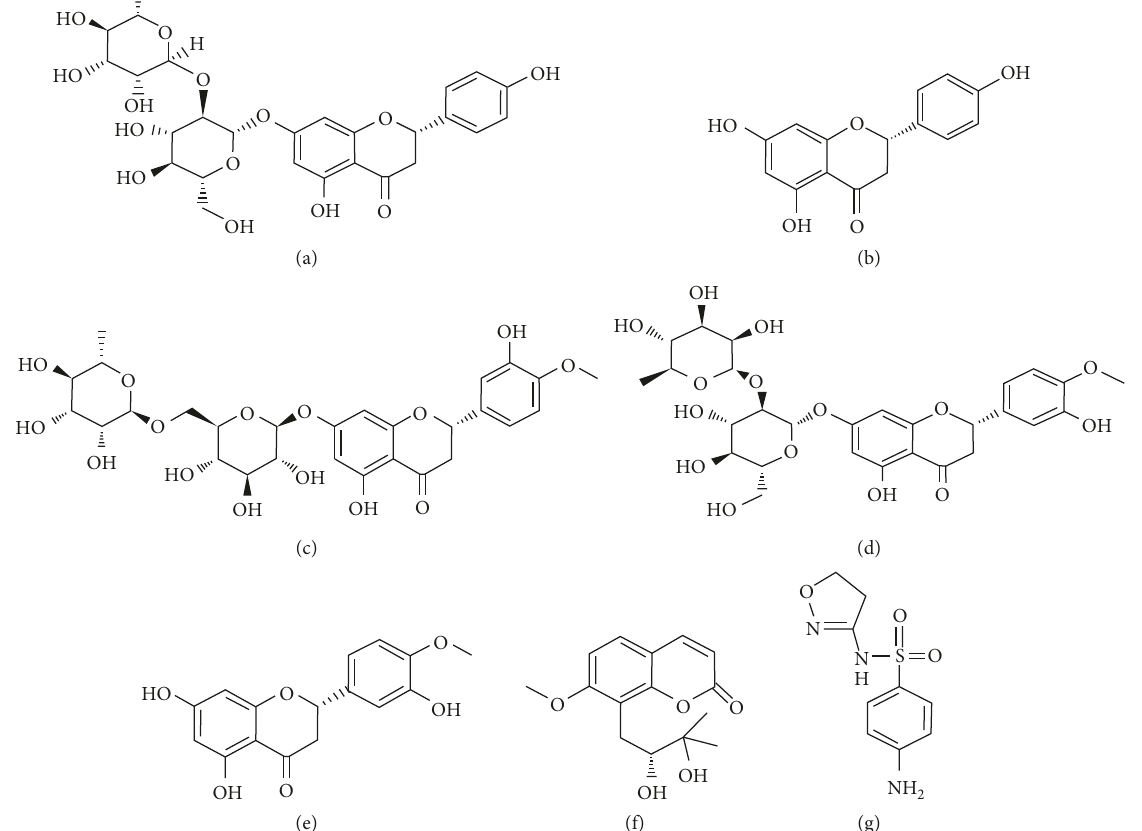
Figure 1: Chemical structures of (a) naringin, (b) naringenin, (c) hesperidin, (d) neohesperidin, (e) hesperetin, (f) meranzin hydrate, and (g) internal standard (IS,